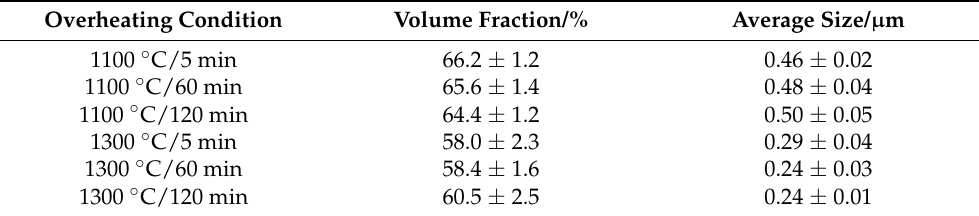
Table 1. The statistical volume fraction and average size of γ ’ particles in the dendrite core regions of the experimental superalloy after overheating.